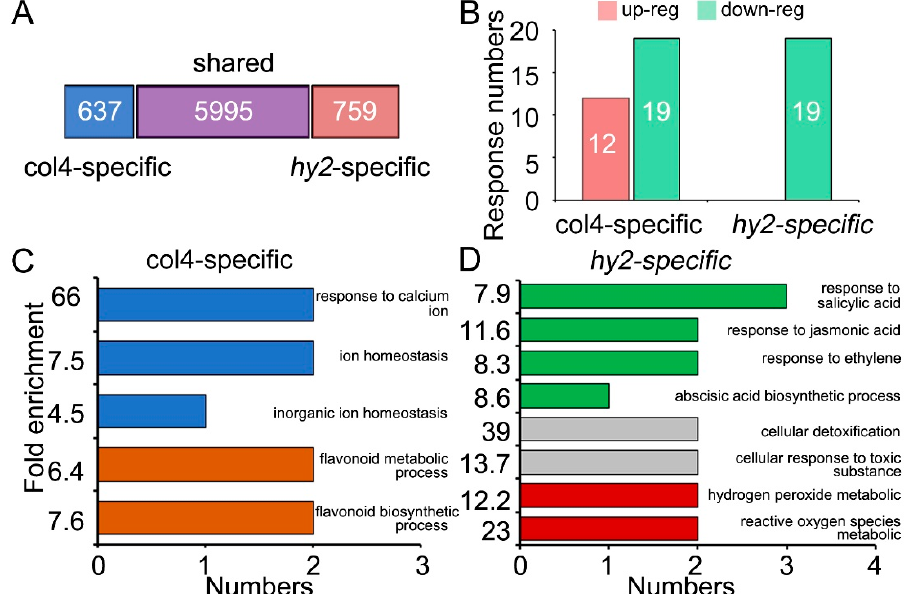
Figure 3. Function analysis of specific quantified proteins. ( A ) The number of specific and shared quantified proteins between col4 and hy2 mutant under salt stress. ( B ) The response number of col4- specific and hy2 -specific DRPs under salt stress. The red and green squares represent upregulated and downregulated proteins, respectively. ( C ) The GO enrichment analysis of col4-specific quantified and response proteins. ( D ) The GO enrichment analysis of hy2 -specific quantified and response proteins.